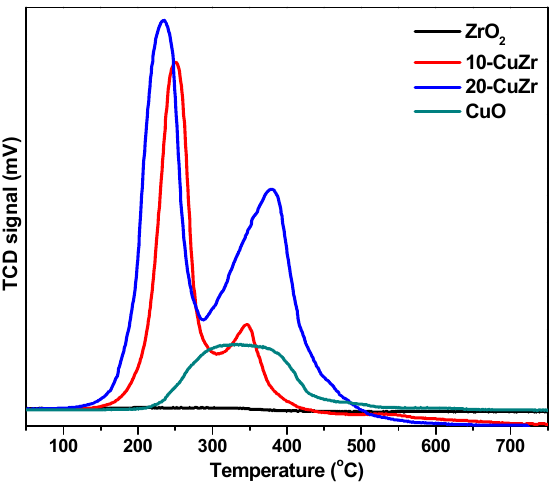
Figure 5. H 2 -TPR patterns of all the Figure 5. H 2 ‐ TPR patterns of all the samples.